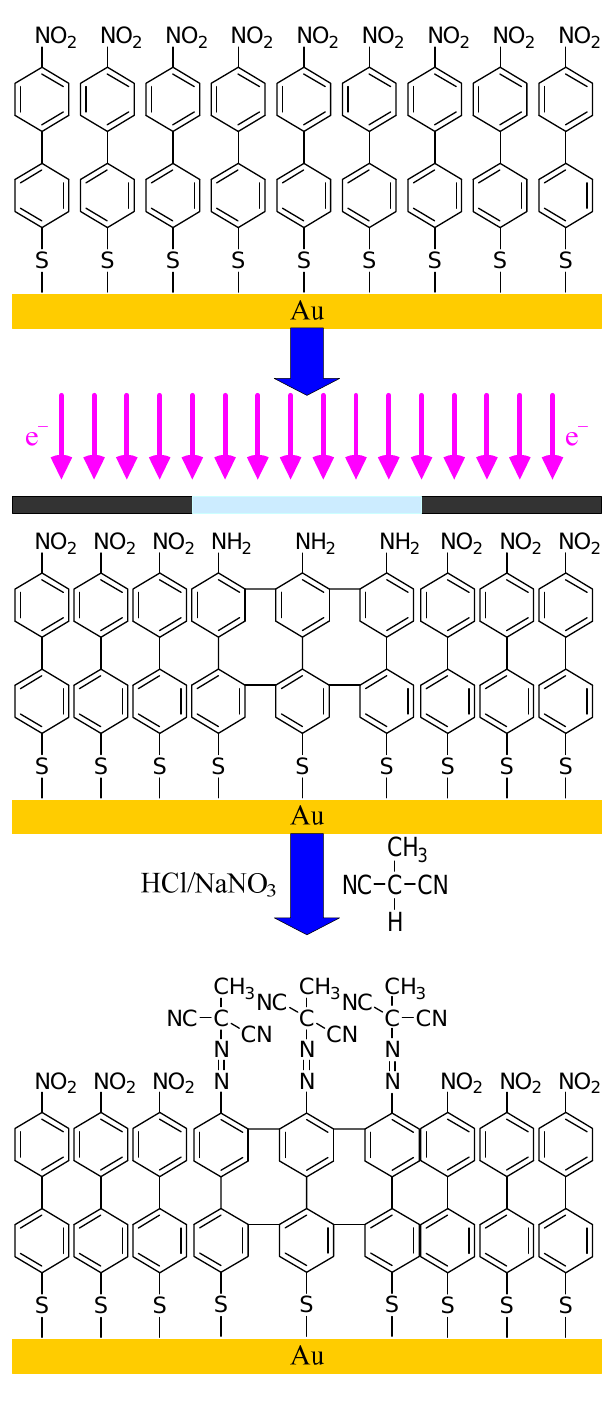
Figure 10. Irradiation through a mask, conversion of the terminal nitro group in amine group and diazotization and coupling with malonodinitrile gives a SAM that bears an asymmetric azo-initiator. Reprinted from Reference [128] with